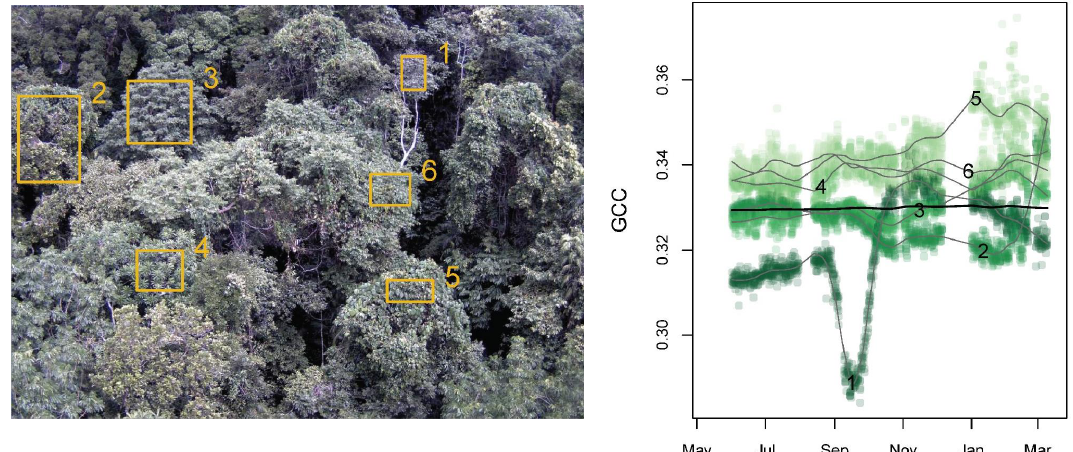
Figure 3. Green chromatic coordinates (GCC) for six individual tree crowns (indicated by orange regions of interest) at the Cow Bay tropical rainforest OzFlux site (Fig. 2; site 1, AU-Cow), Queensland, Australia. Leaf shedding and flushing events (note especially Tree 1, Wrightia laevis , and Tree 2, Acmena graveolens ) are highly specific to individual trees. Black line represents GCC from the full camera field of view. See Fig. 4 for example region of interest variability over